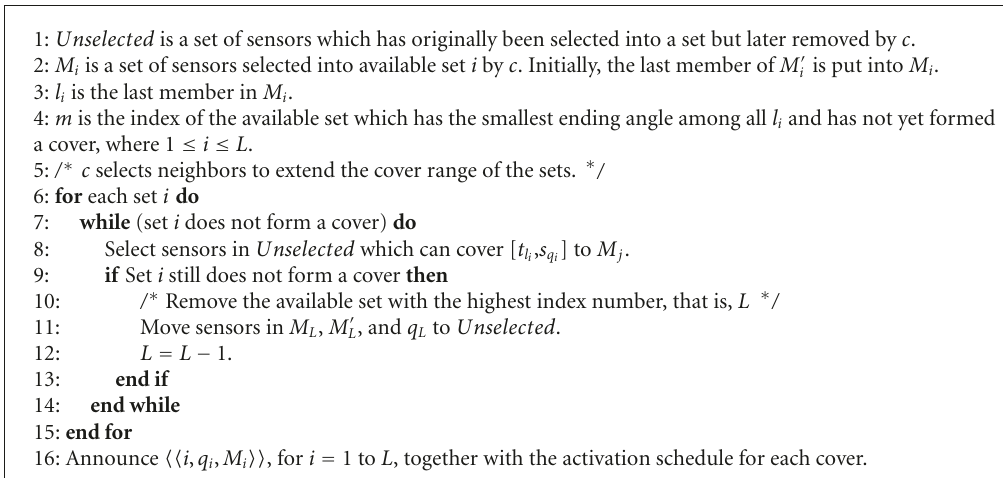
(cid:11)(cid:11) L